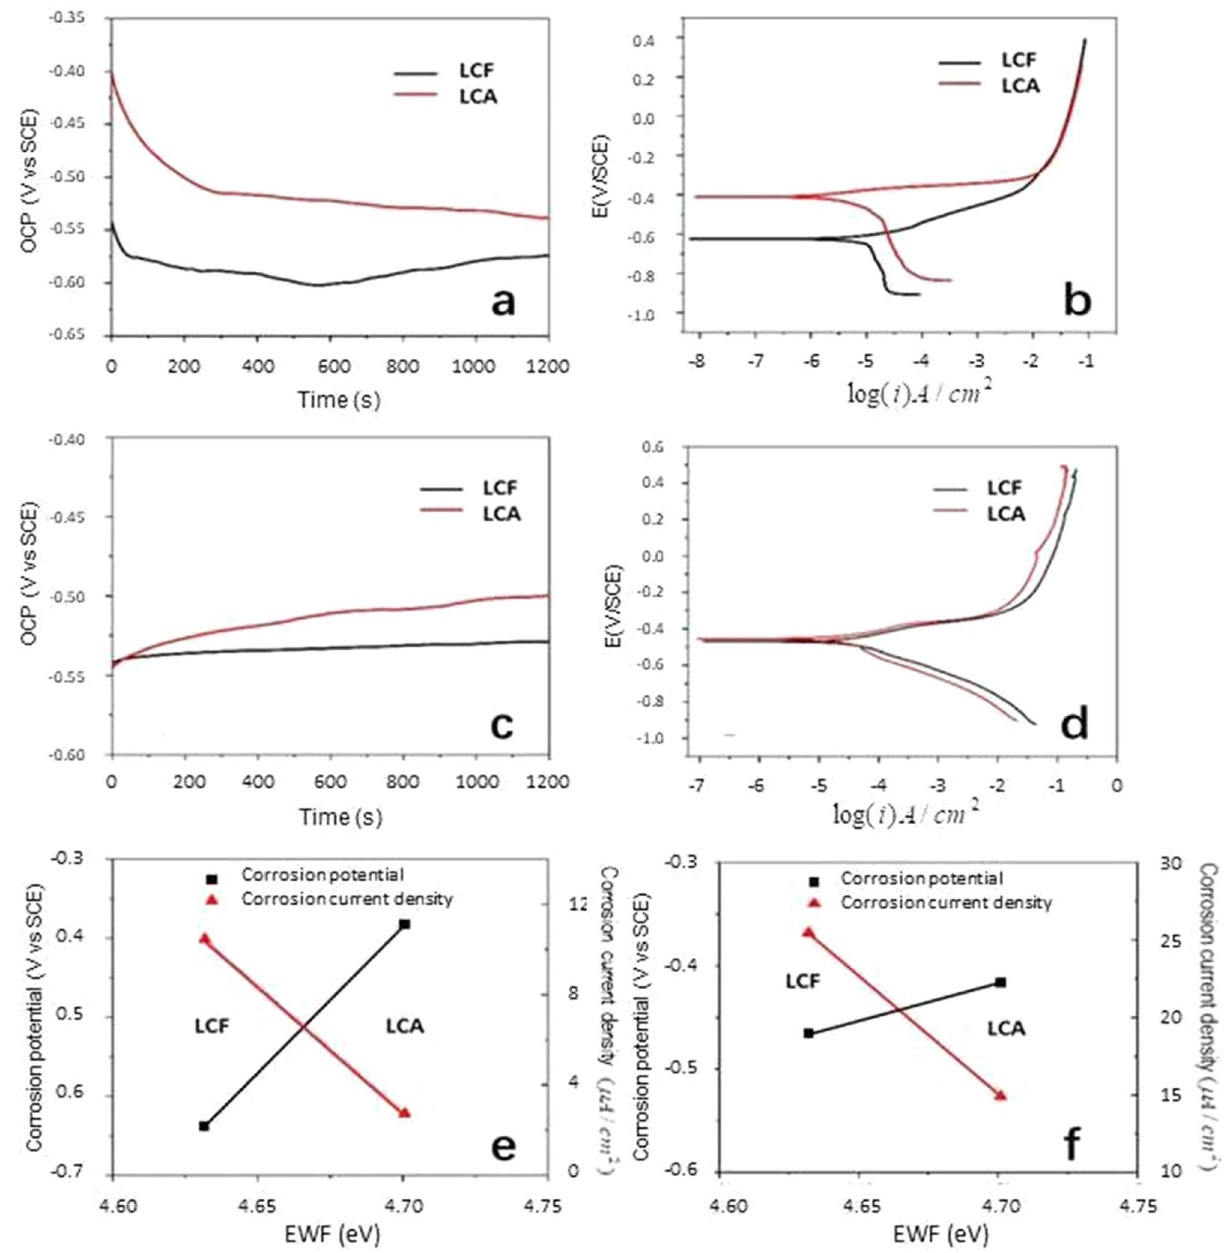
Figure 4. ( a ) Open circuit potentials and ( b ) polarization curves of samples LCF and LCA in 3.5 wt% NaCl solution; ( c ) Open circuit potentials and ( d ) polarization curves of samples LCF and LCA in 0.5 mol/L HCl solution; Relationship between EWF and corrosion potential, corrosion current density of the samples in 3.5 wt% NaCl solution ( e ) and 0.5 mol/L HCl solution ( f ).